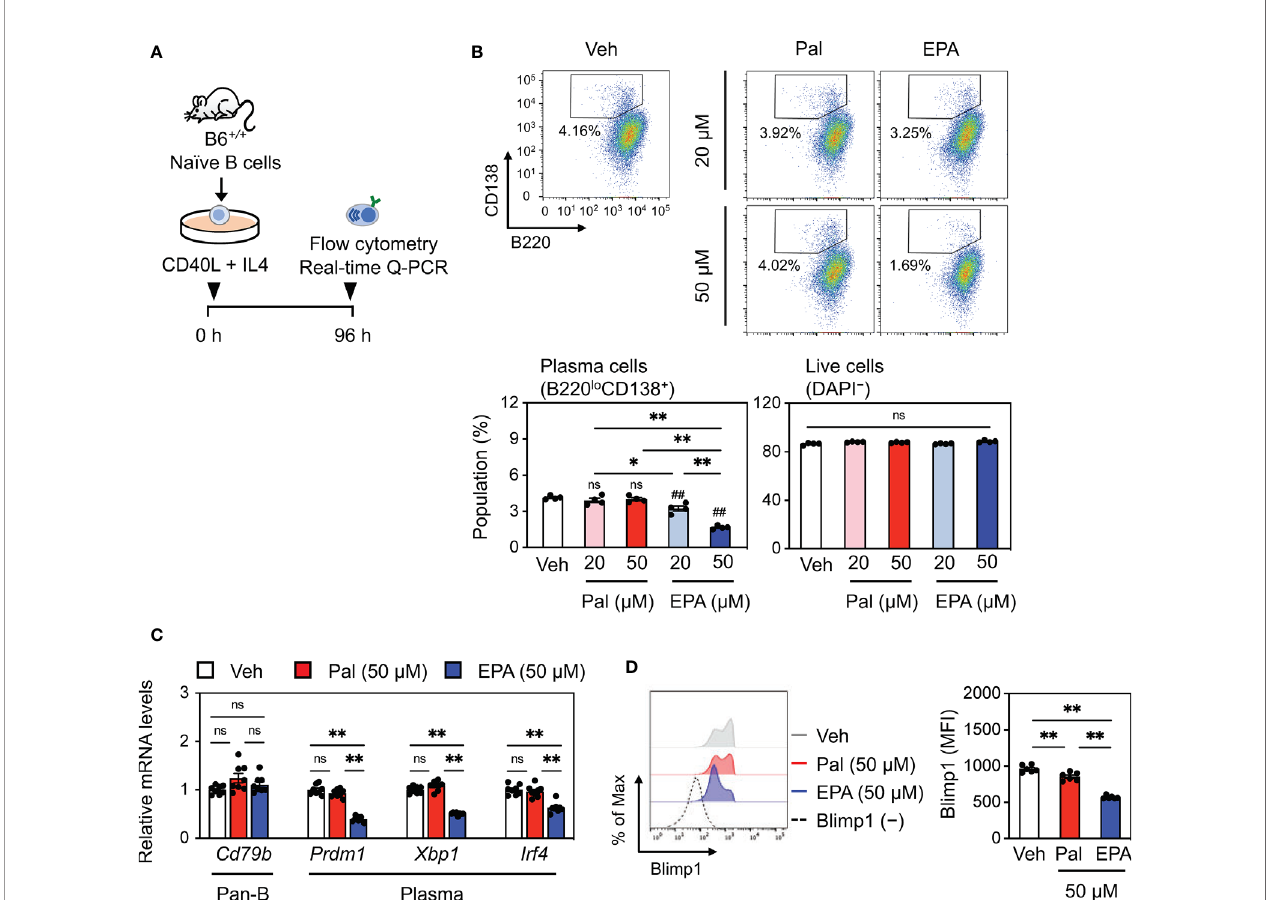
FIGURE 6 | EPA directly inhibits plasma cell differentiation. (A) Experimental protocol. Naïve B cells isolated from B6 +/+ spleen were stimulated with CD40L (1 m g/ml) and recombinant murine interleukin-4 (IL4, 3 ng/ml) in the presence of ethanol (Veh), Pal (~50 µM) or EPA (~50 µM) for 96 h. (B) Representative fl ow cytometry plots (top) and percentages of B220 lo CD138 + plasma cells (bottom, left) and live cells (bottom, right) analyzed by fl ow cytometry. (C) Gene expression of B cell markers. (D) Representative histogram (left) and mean fl uorescence intensity (MFI, right) of Blimp1 in live cells. n = 4 per group. Data shown are mean value ± SEM of representative experiments at least three times independently. Statistical analysis was performed with Tukey ’ s test. *p < 0.05; **p < 0.01; ns, not signi fi